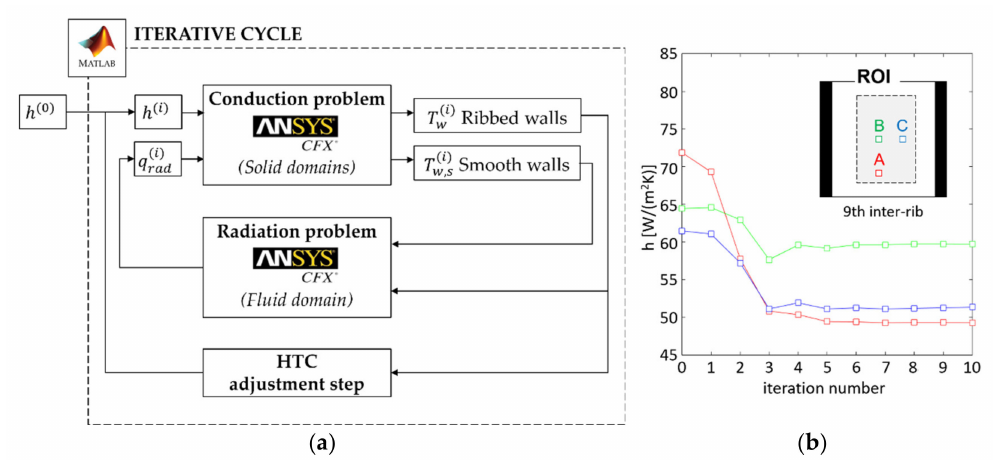
Figure 5. Iterative procedure for steady-state data elaboration: ( a ) block diagram; ( b ) example of the heat-transfer coe ffi cient (HTC) value convergences history for the static